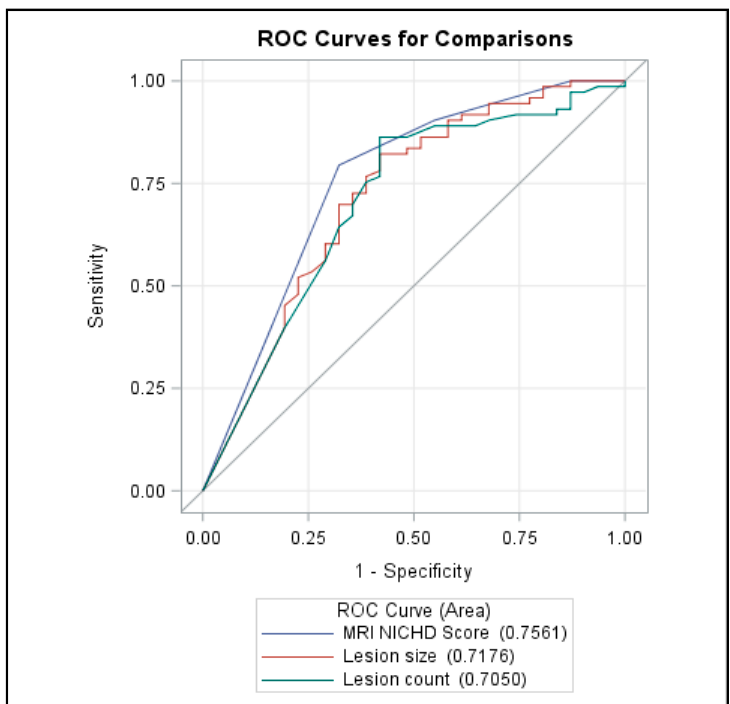
Figure 2. Receiver Operating Characteristic (ROC) curves for comparisons between MRI National Institute of Child Health and Human Development (NICHD) score (location) and lesion size and count.